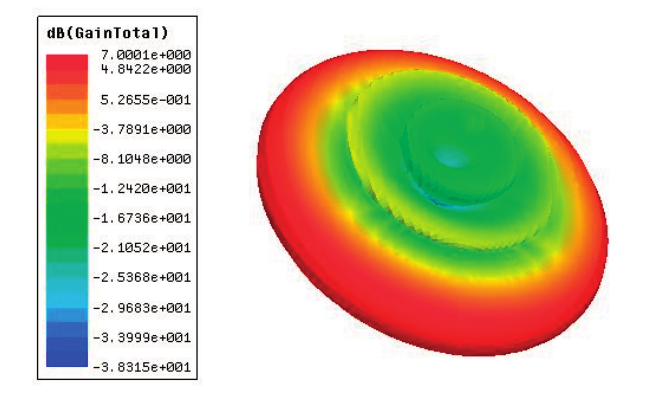
Figure 9. Simulation result showing the top view of the radiation beam pattern.